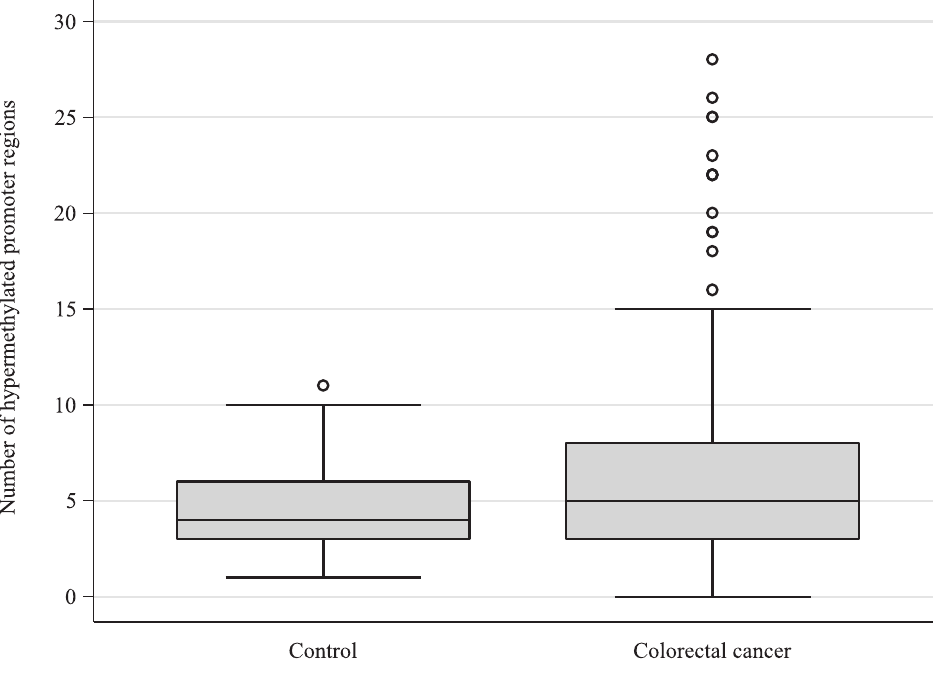
Fig 1. Number of methylated promoter regions according to patient